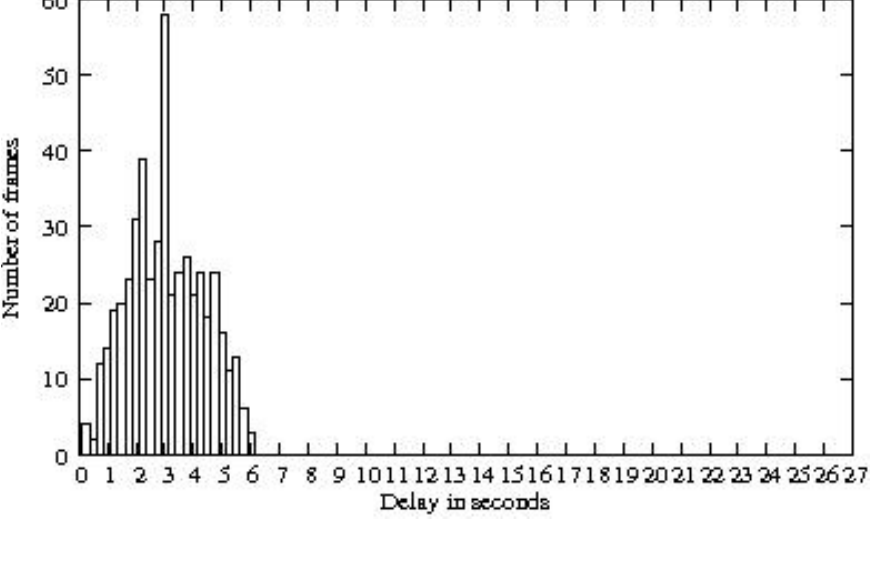
Figure 14. Percentage of time a node is awake in the active